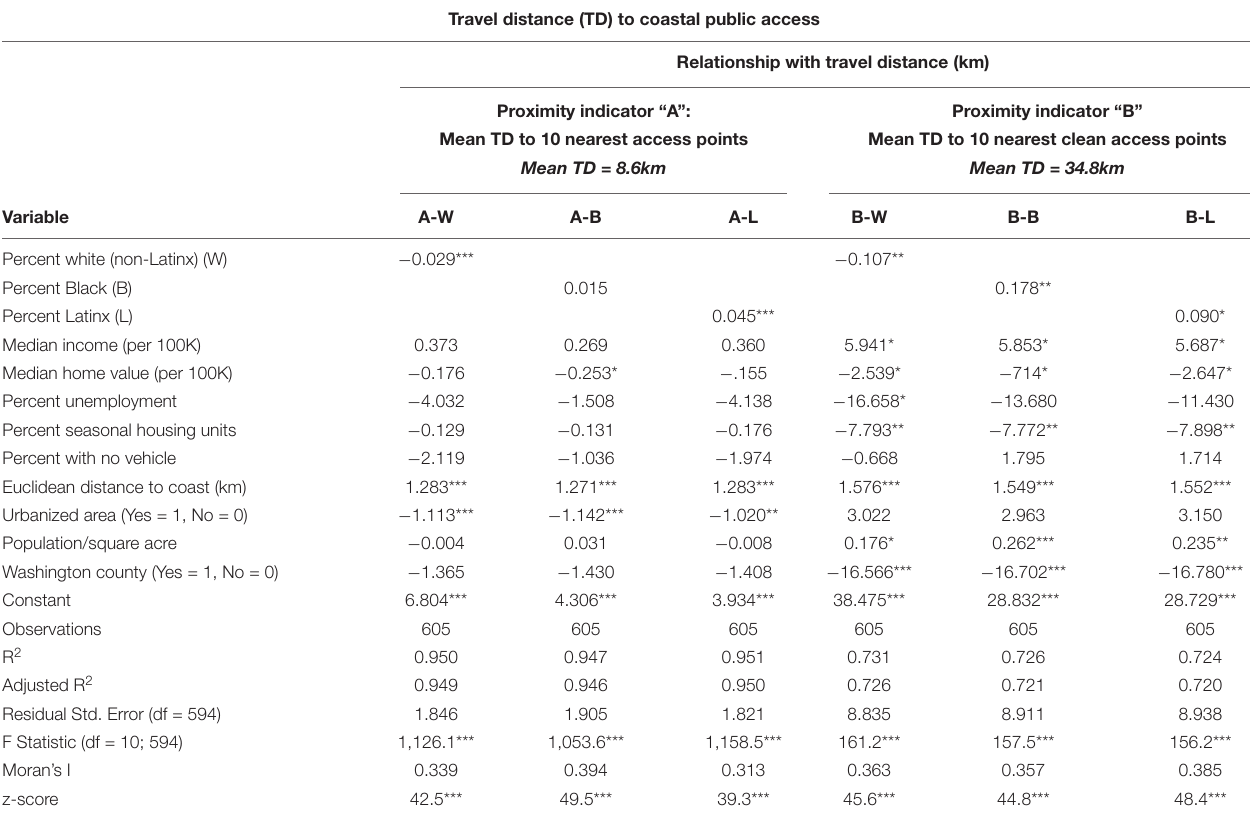
TABLE 4 | Linear regression results for proximity indicator (A) mean travel distance (TD) in kilometers to the nearest ten public access points and (B) mean TD to the nearest ten clean public access points, each run separately for race/ethnicity variables percent non-Latinx white (W), percent Black (B), and percent Latinx (L). Travel distance (TD) to coastal public